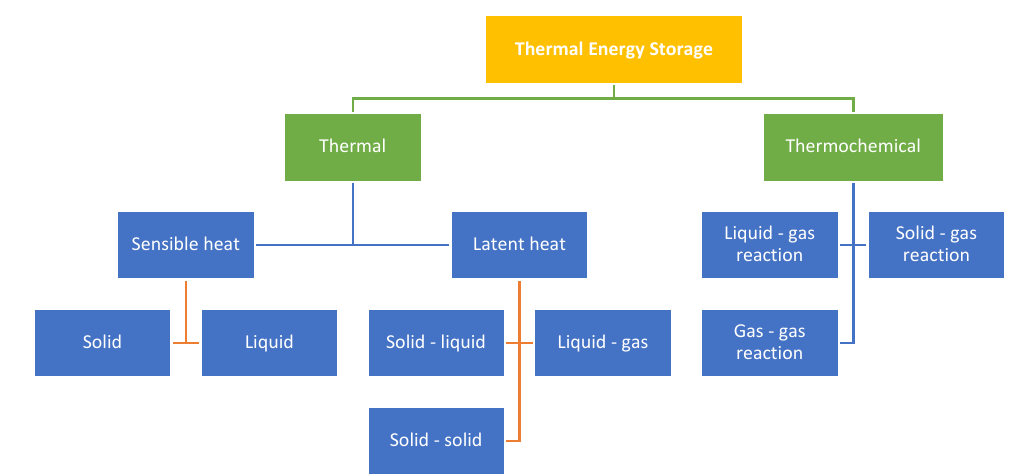
Figure 1. Classifications of thermal energy storage systems [7].